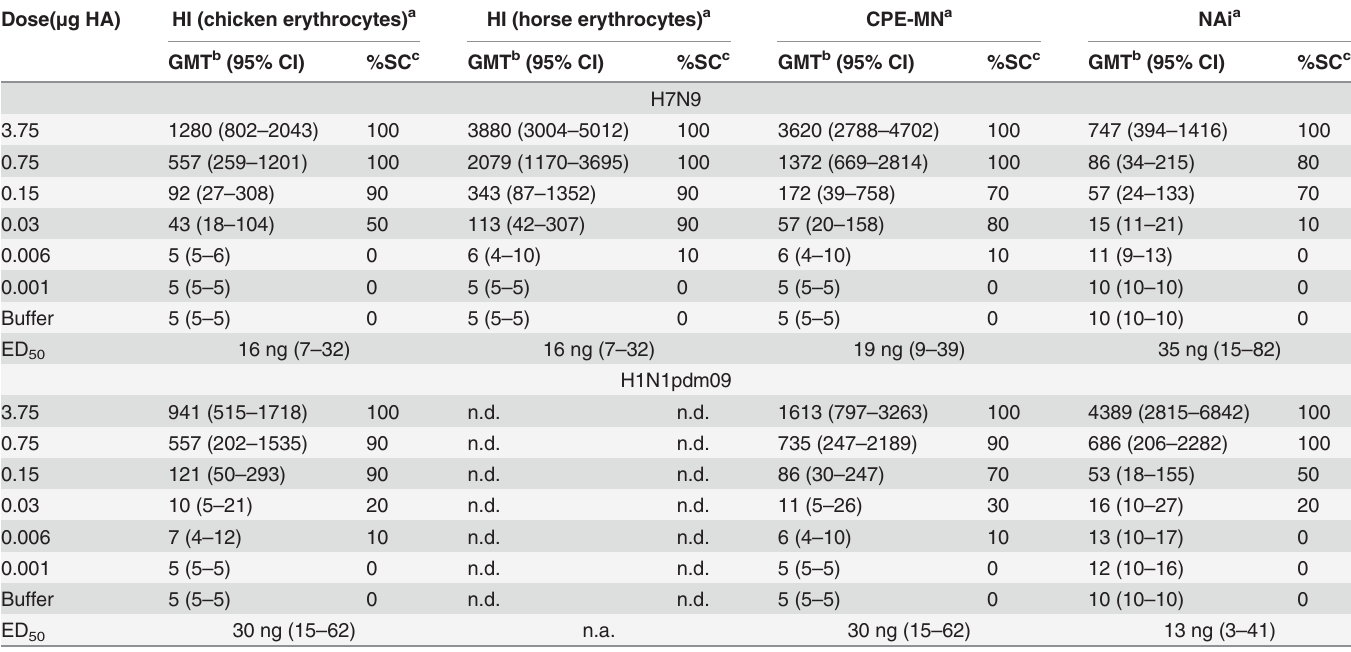
Table 2. HA and NA antibody responses induced by H7N9 and H1N1pdm09 vaccines in guinea pigs. Dose( μ g